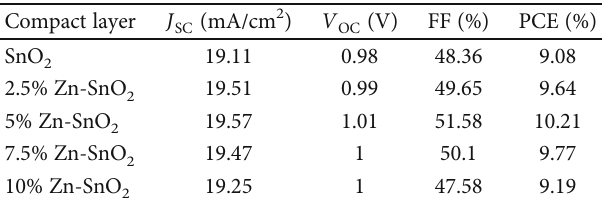
Figure 7: J ‐ V curves of PSCs based on Zn-SnO with di ff erent doping concentrations. Table 1: Photoelectric parameters of PSCs based on Zn-SnO compact layers with di ff erent doping